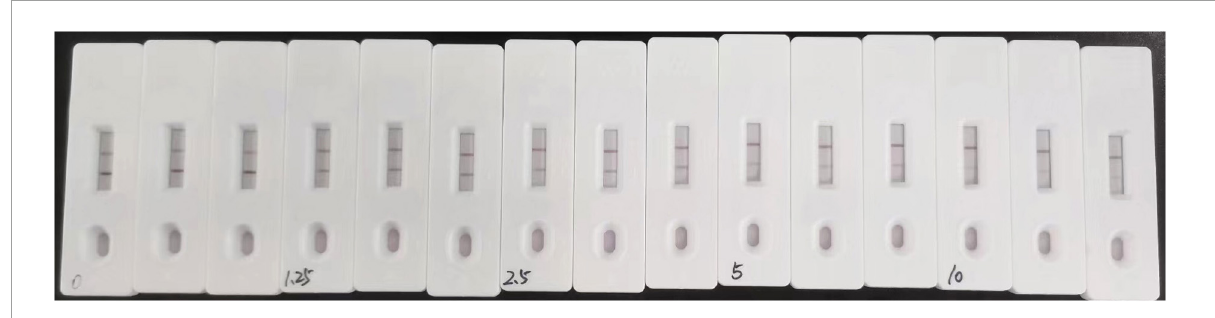
FIGURE3 Colloidal gold immunochromatography assay for aldicarb in standard solution.